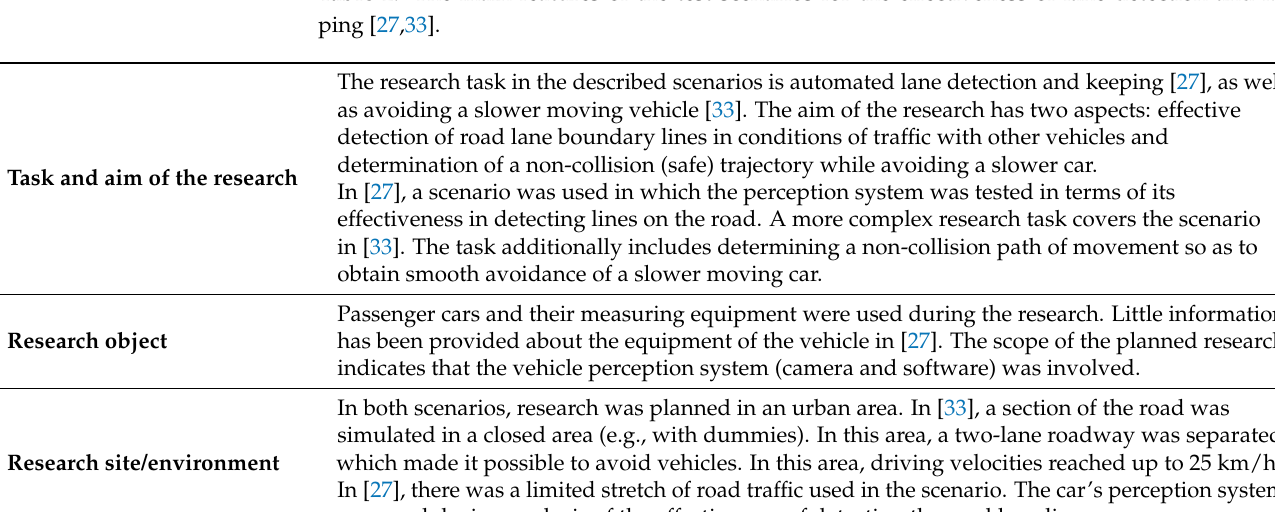
Table 2. The main features of the test scenarios for the effectiveness of lane detection and kee- ping